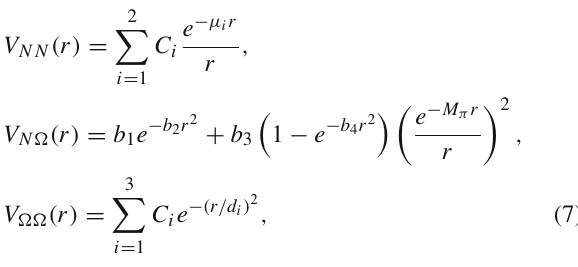
a six-dimensional hypersphere coordinate, ρ = is the hyperradius, α = arctan ( r 2 / r 1 ) is the